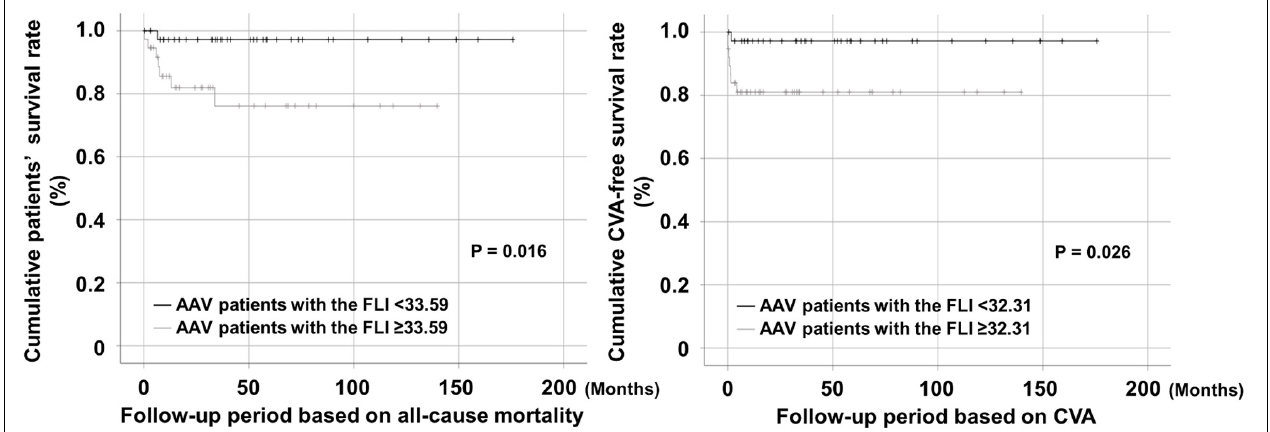
FIGURE 2 | Comparison of cumulative survival rates. AAV patients with the FLI ≥ 33.59 and that ≥ 32.31 at diagnosis exhibited significantly lower cumulative patients’ and CVA-free survival rates than those without, respectively. AAV, ANCA-associated vasculitis; ANCA, antineutrophil cytoplasmic antibody; FLI, fatty liver index; CVA, cerebrovascular